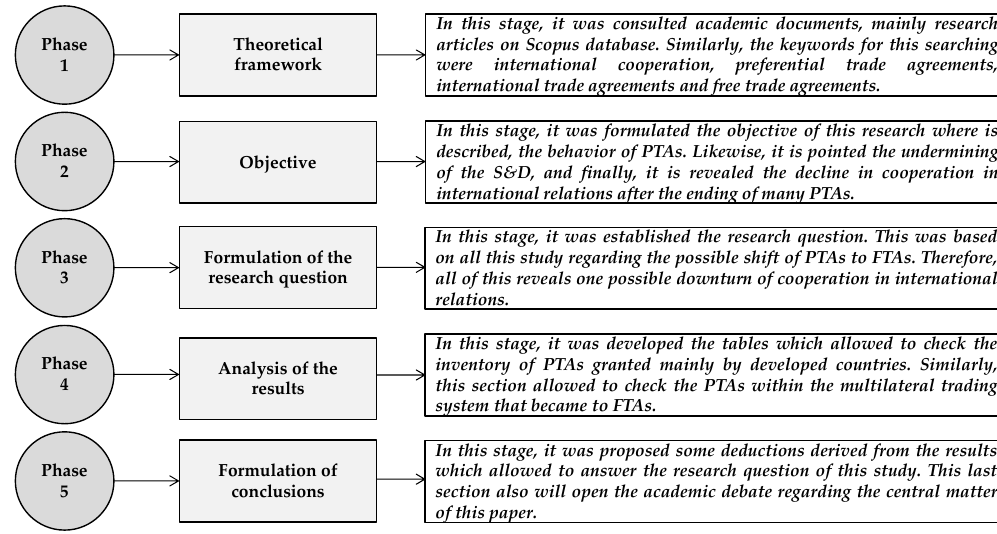
Figure 1. Phases of the research for the current subject of study. Source: Own elaboration based on Quecedo and Castaño (2002); Healy and Perry (2000) and Giddens and Sutton (2013).